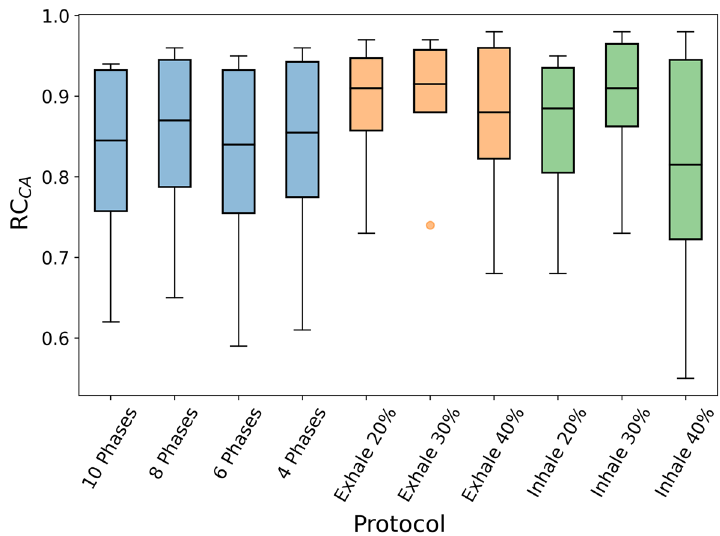
Fig. 11 Boxplots of the activity concentration RC per